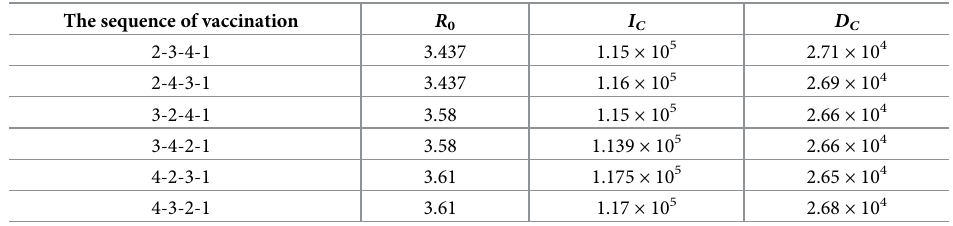
Table 6. R 0 , I C and D C were inoculated in six sequences,